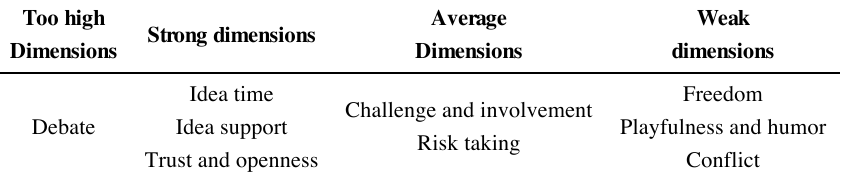
Table 8. Strengths and weaknesses of the company’s technological innovation climate Too high